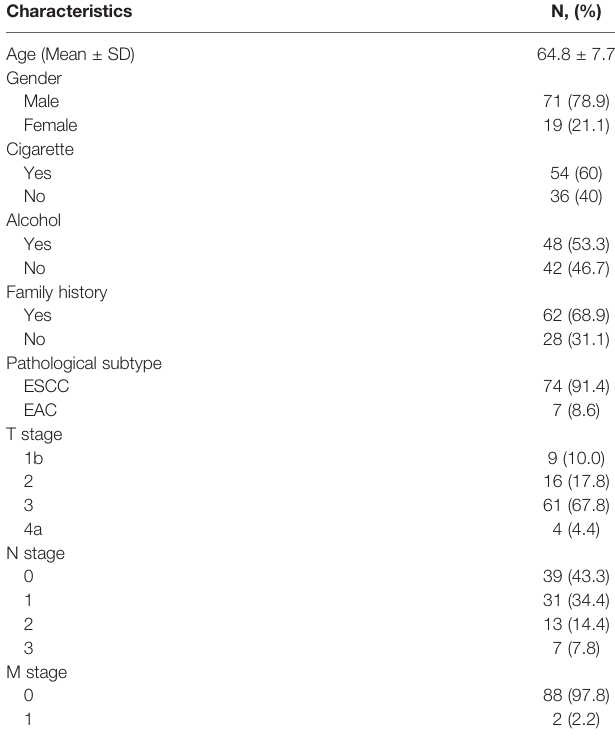
TABLE 1 | General characteristics of participants.